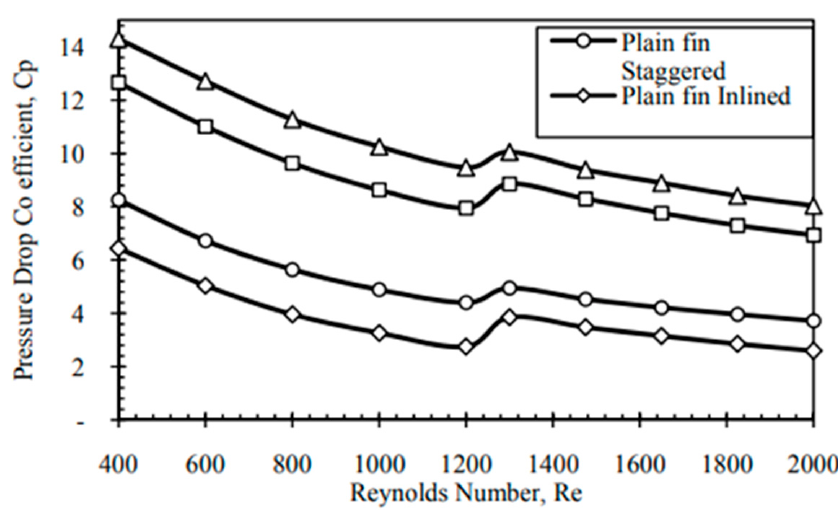
Figure 13. Impact on pressure drop coefficient for different fin configurations [65].